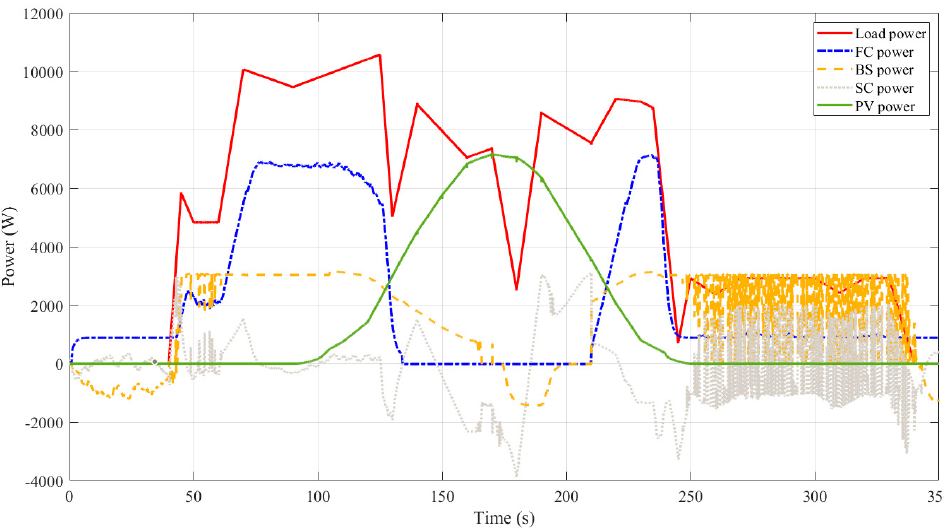
Figure 11. Dynamic produced power by different hybrid system components using WSO.